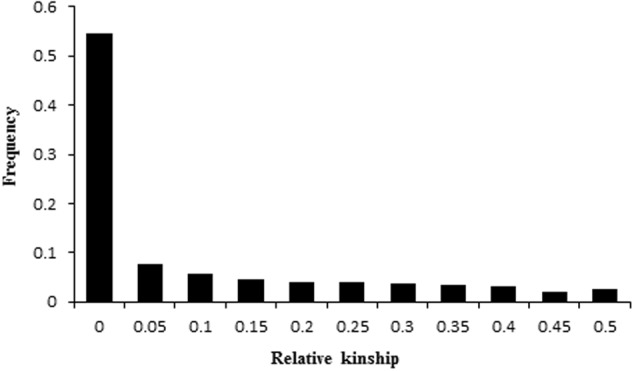
Distribution of pairwise relative kinship estimates. Only percentages of relative kinship estimates ranging from 0 to 0.5 were shown.